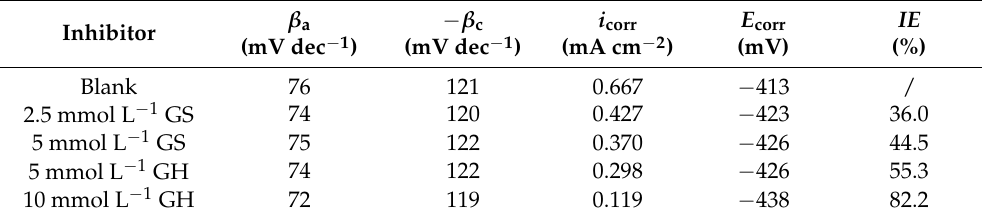
Figure 1. PDP curves of the electrodes in 0.5 mol L − 1 H 2 SO 4 solution without and with various amounts of glucosamine salts. Table 2. Tafel fitting results of the electrodes in 0.5 mol L − 1 H 2 SO 4 solution without and with various amounts of glucosamine salts.